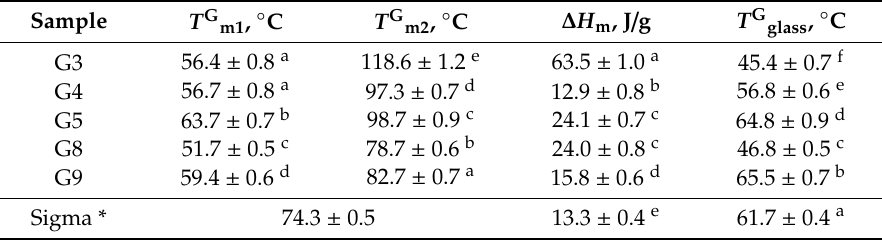
Table 6. Thermal properties of cod gelatin obtained at different pH.